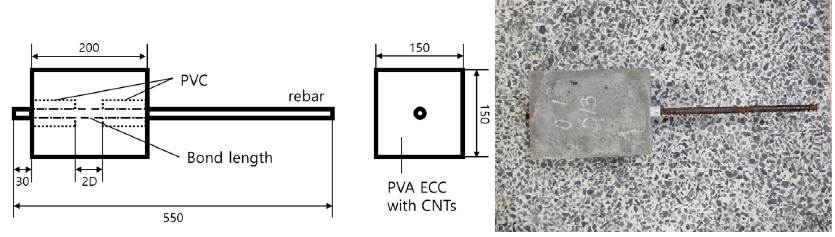
Figure 3. Pullout test specimen and its geometrical configuration.